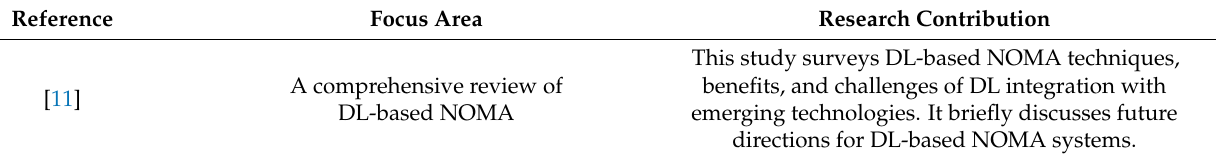
Table 1. Summary of recent reviews on DL-based